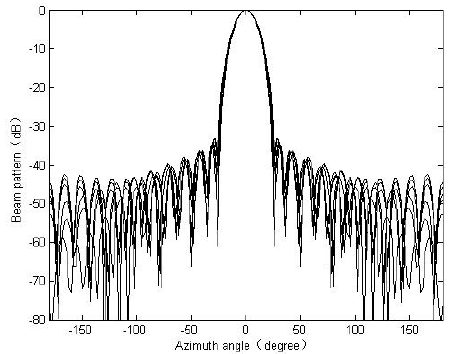
Algorithms 2019 , 12 , x FOR PEER REVIEW 11 of 13 Figure 9. Superposition of measured array manifold at six frequency points.